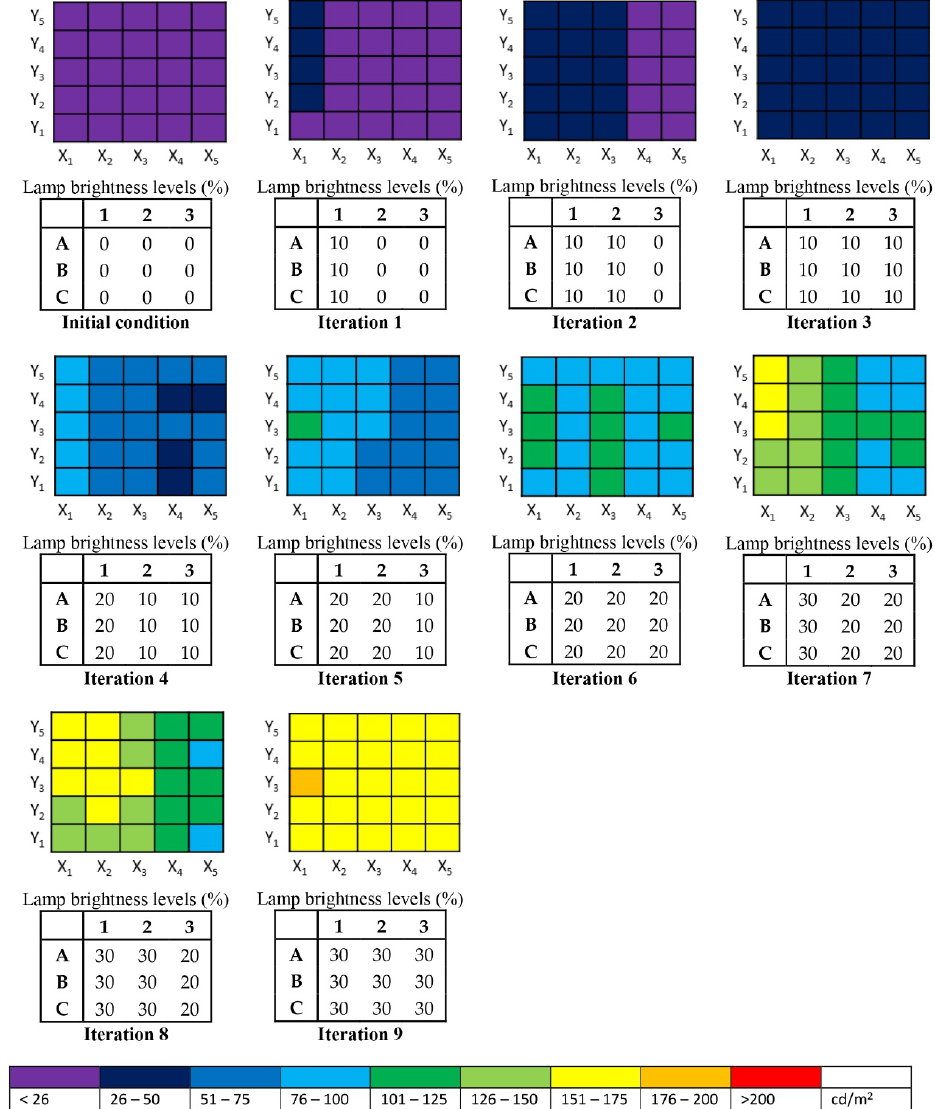
Figure A1. The luminance values and lamp brightness levels of Measurement Scheme 1A in each iteration. The lamps brighten in the sequence of L 1 , L 2 , and L 3 .